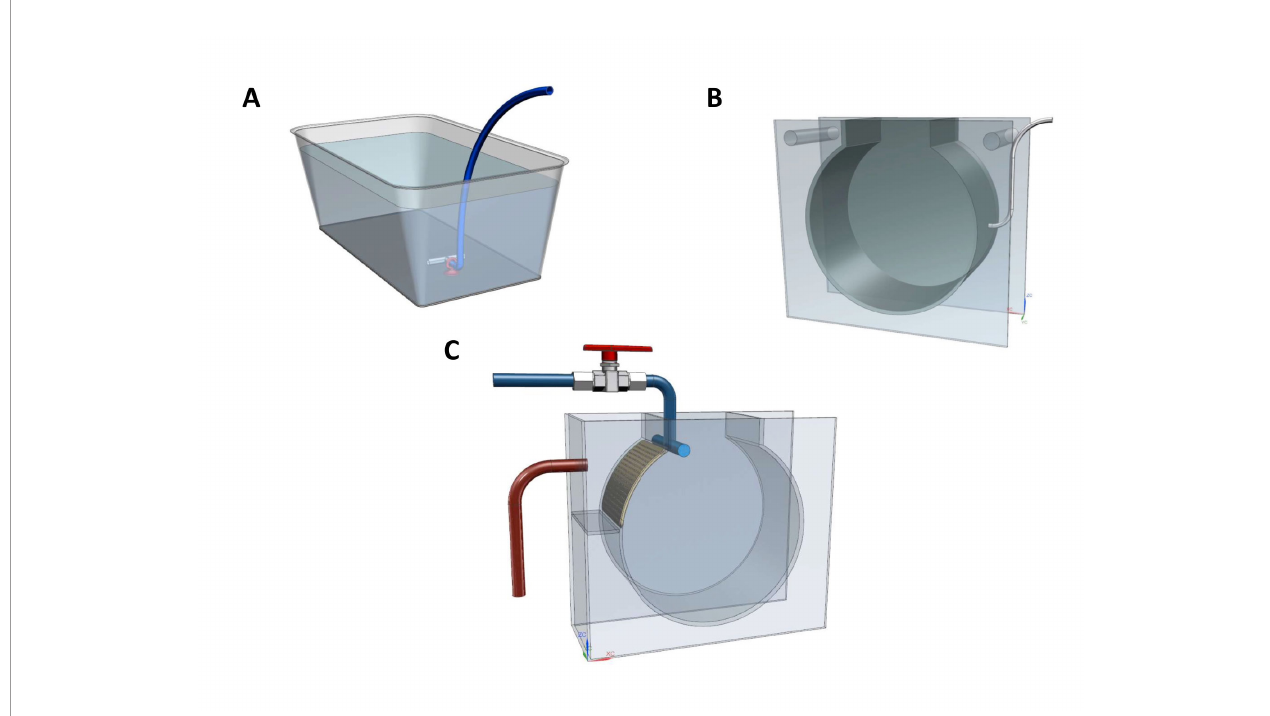
FIGURE 1 | Types of rearing vessels and tanks used for Pelagia noctiluca during the experiments. (A) Culture establishment from fertilized eggs to fi rst ephyrae. (B) Air-kreisel tank for the farming of early stages. (C) Water-kreisel tank for the breeding of advanced stages. Illustrations by Carlos